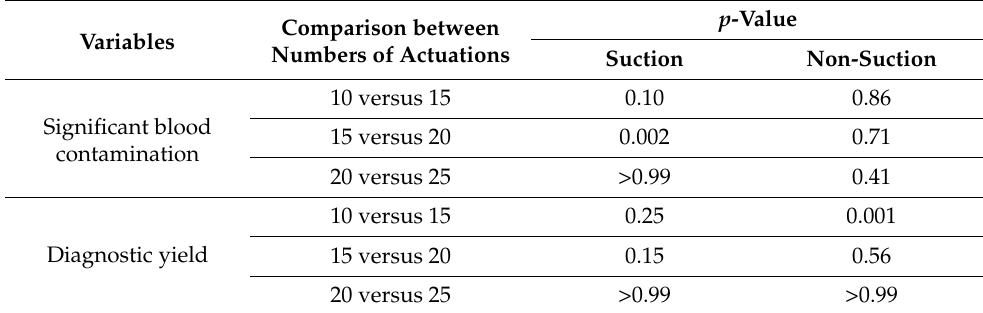
Table 3. Repeated contrast among the number of needle actuations (per needle pass, study I).